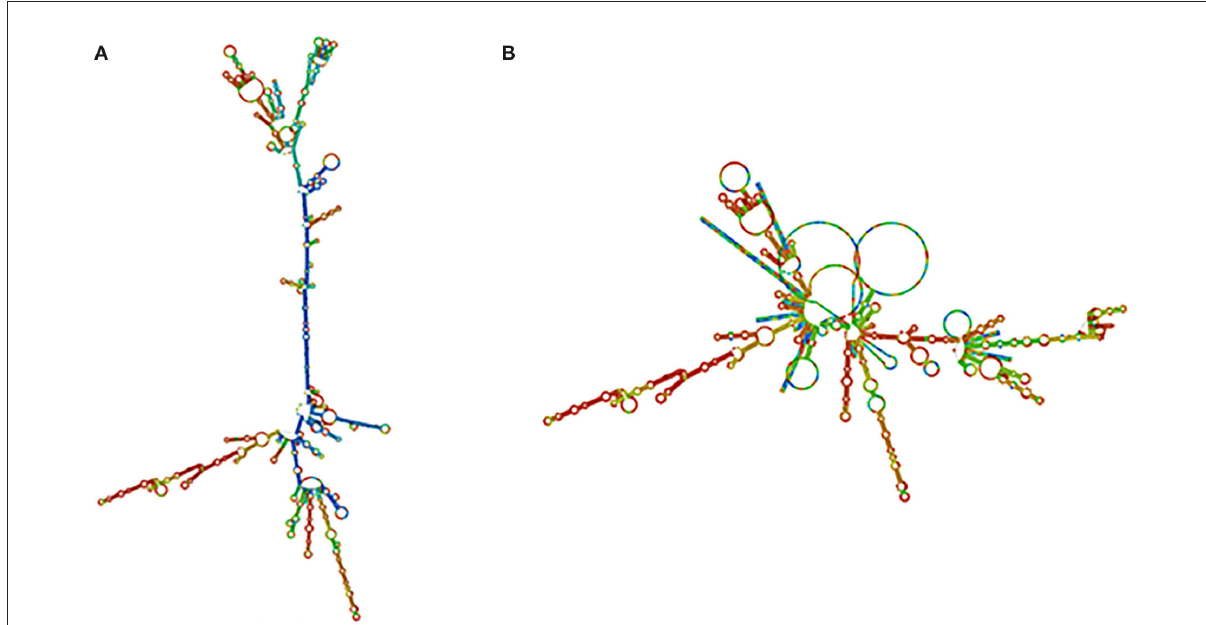
FIGURE6 mRNA structure prediction. (A) Optimal secondary structure. (B) Centroid secondary structure of the vaccine mRNA retrieved using RNA-fold web server.